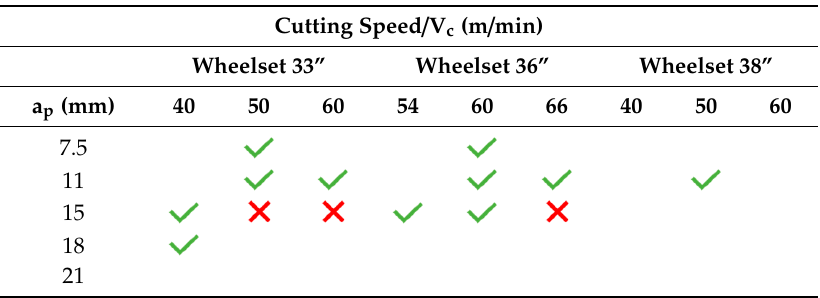
Table 1. Cutting test results.